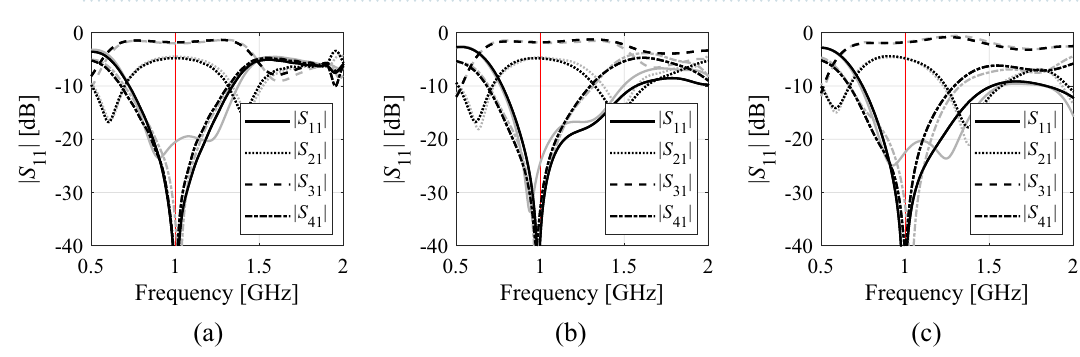
Figure 8. Structure I responses obtained in selected runs of the proposed algorithm: ( a ) run 1, ( b ) run 2, ( c ) run 3: design found after the global search stage (- - -), final design (—). Vertical lines mark the target operating frequencies, here 2,45 GHz and 5,3 GHz.